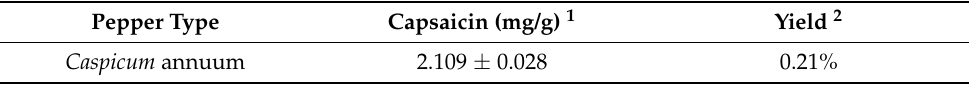
Table 1. HPLC quantification of Capsaicin from extracts and extraction yield. Pepper